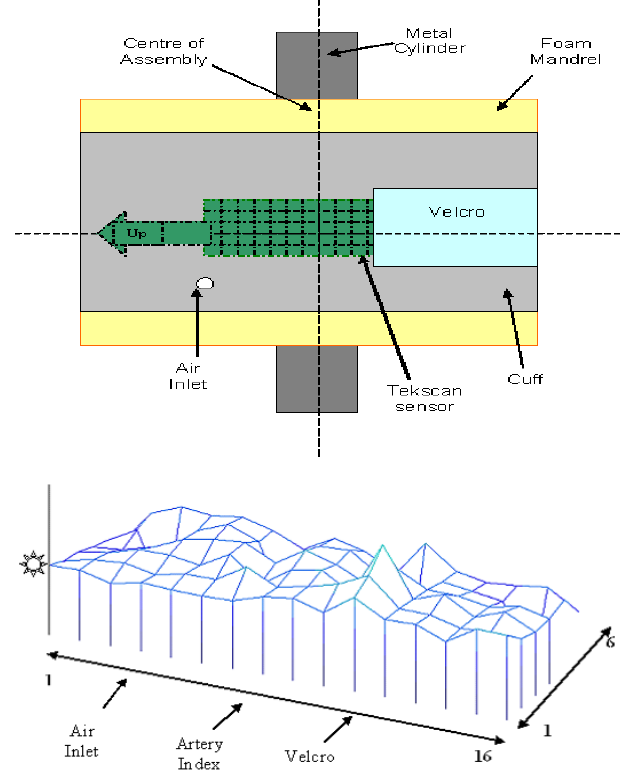
Fig. 3(a) Tekscan sensor arrangement for measurement of pressure at interface of metal cylinder and Cuff 2W, cuff 4W and cuff 5W